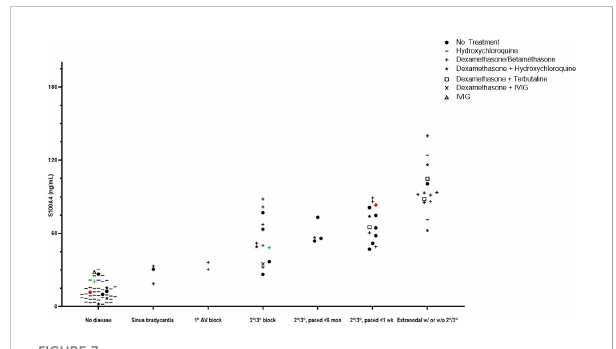
FIGURE 7 Evaluations of cord blood with an association of levels of S100A4 and severity of disease. Access to a cohort of anti-Ro+ mothers at delivery who consented to donate umbilical cord blood of their neonate was leveraged to interrogate levels of S100A4 and fetal manifestations. Each point represents an individual subject. A comparison of median levels of S100A4 detected in the (n=49) cardiac-NL neonates compared to the (n=47) anti-SSA/Ro+ exposed, unaffected neonates was conducted via the Mann-Whitney U test (61.6 ng/mL vs. 12.0 ng/mL respectively, p<0.0001). At the x-axis, groups of subjects appear from low to high severity. In addition, there are colored dots representing discordant twin pairs. Maternal treatments during pregnancy are re fl ected in the data points and de fi ned in the legend insert on the